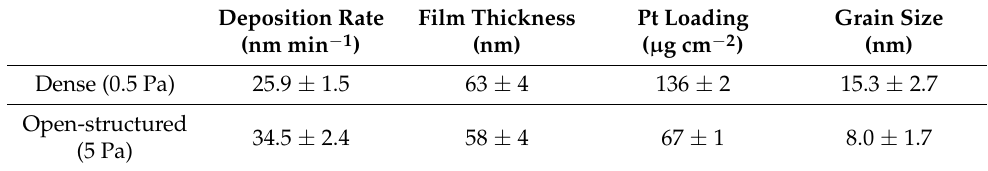
Table 1. Platinum film growth rates at different working gas pressures and properties (method) of the associated dense and open-structured thin films, including film thickness (tactile profilometer), platinum loading (ICP-OES) and grain size (SEM).